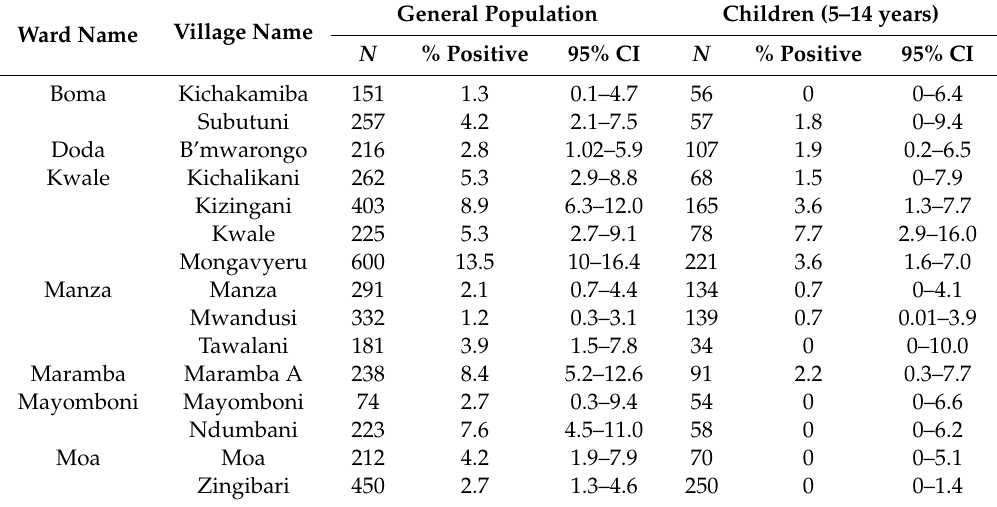
Table 2. Distribution of CFA positivity rate by village’s general study population and in children aged 5–14 years.